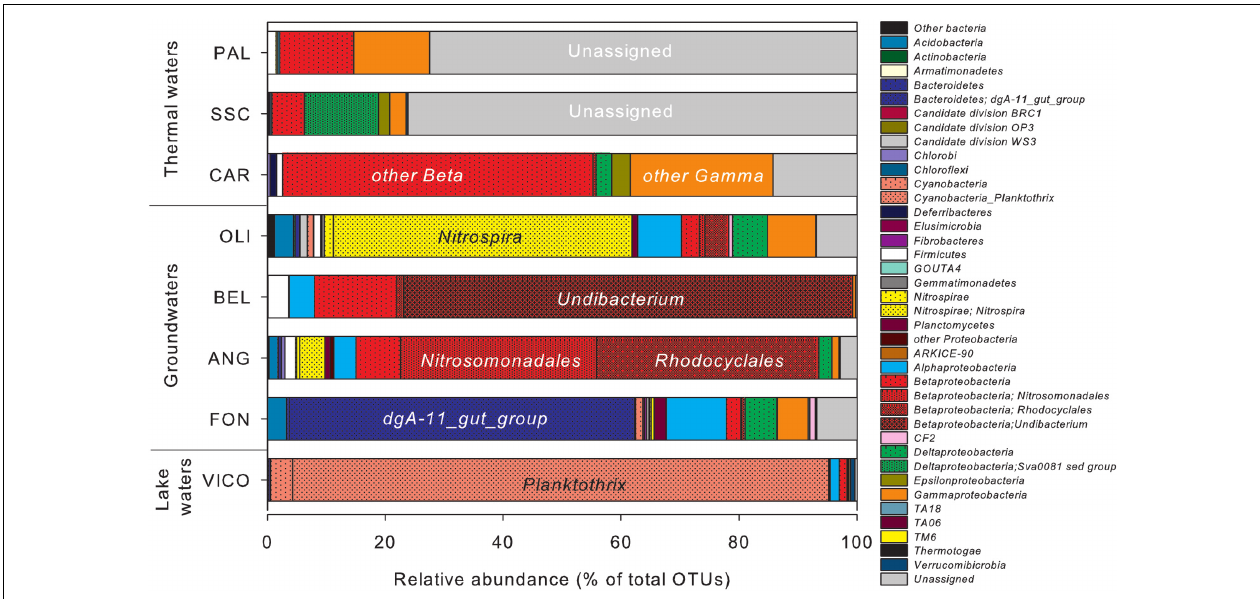
(Liao et al., 2011; Davolos and Pietrangeli, 2013; Paul et al.,